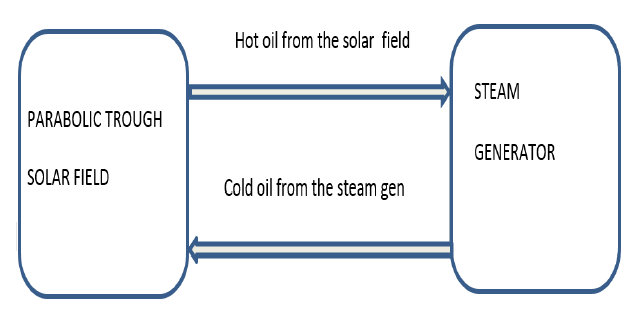
Figure 3. Solar plant scheme.